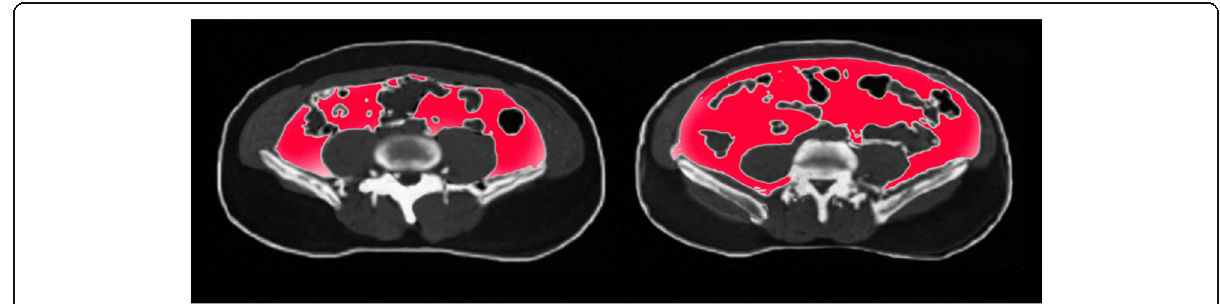
Fig. 7 Men matched for the same BMI and total body fat: Differing ‘ adiposity phenotypes ’ regarding visceral obesity and subcutaneous obesity and with different risk profiles (courtesy: A.